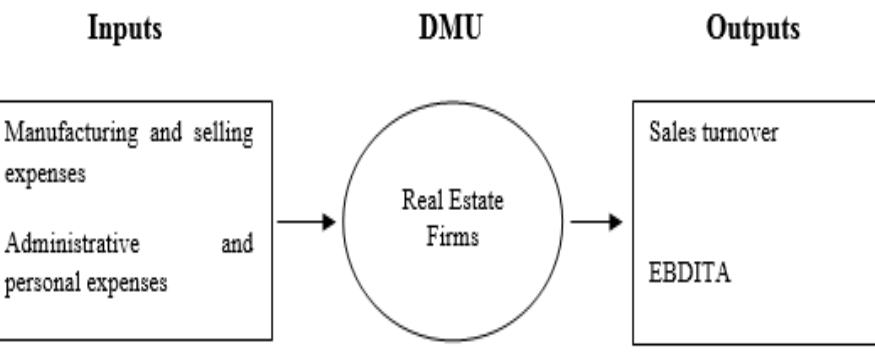
Fig.1. Inputs and outputs (developed by the